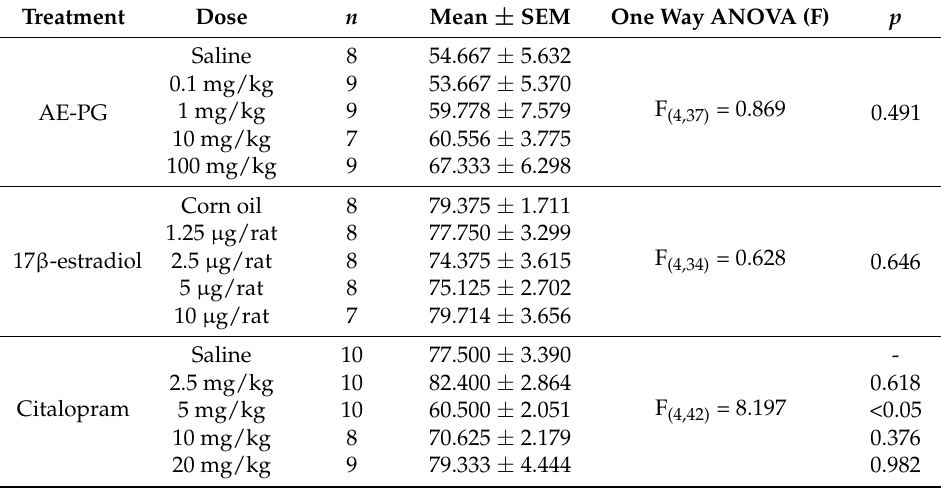
Table 1. Number of crossings in the open-field test with the chronic administration of AE-PG, 17 β -estradiol, and